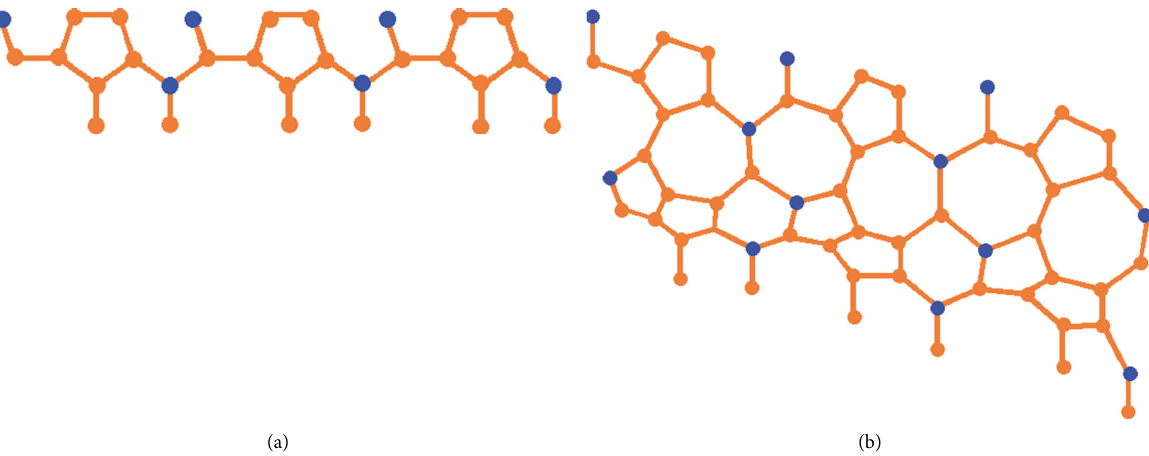
− I [ r, s ] and (b) contains SiC 3